Question: What kind of plot is shown here?
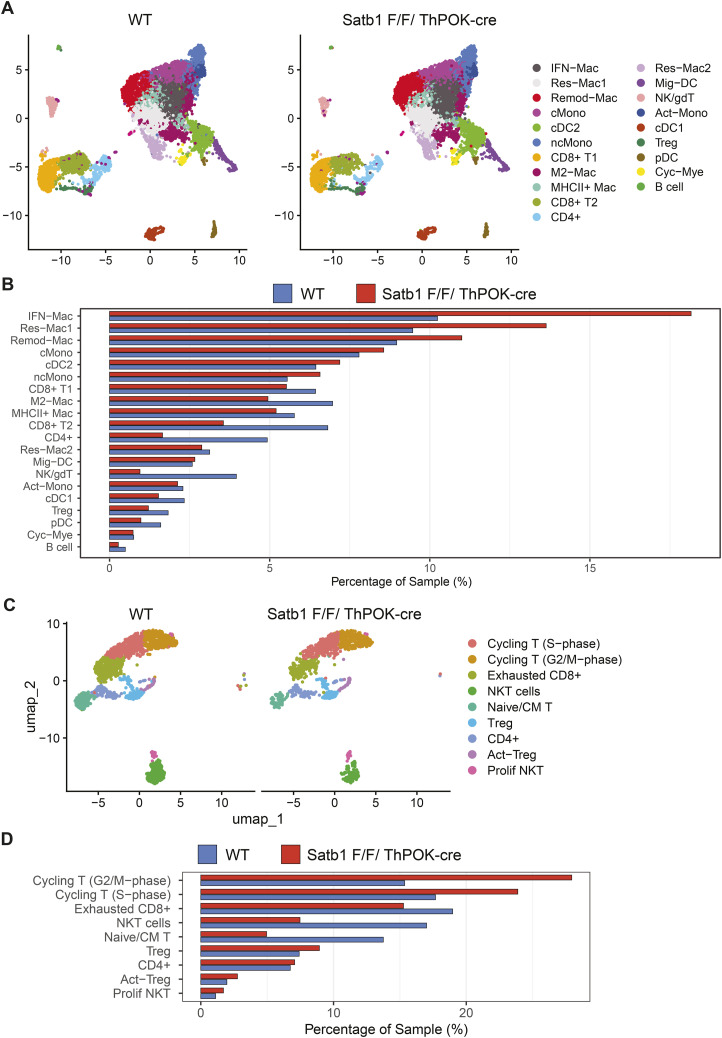
Answer: scatter